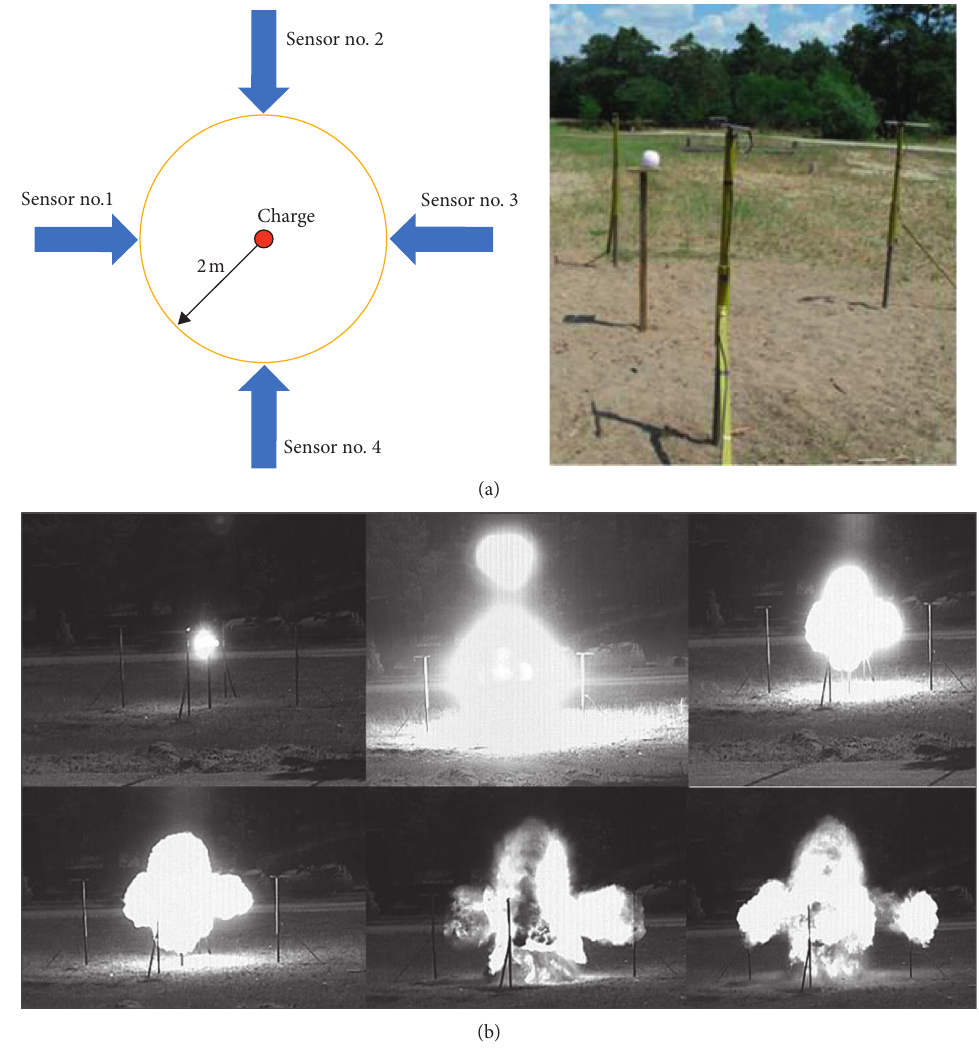
Figure 4: Reference field experiments: (a) setup and (b) sequential propagation of blast waves